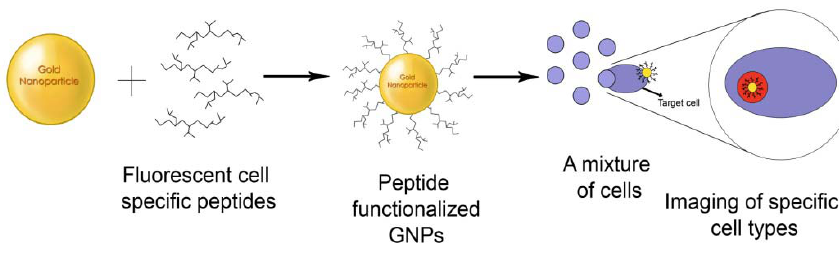
Figure 4. GNPs functionalized with cell specific peptides for